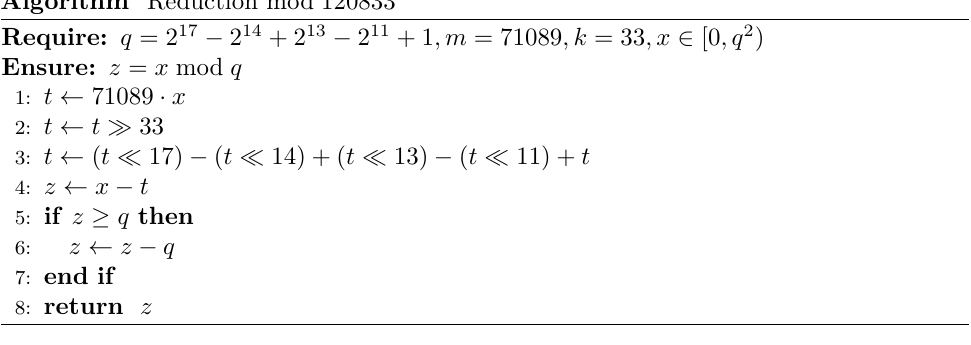
Algorithm Reduction mod 120833